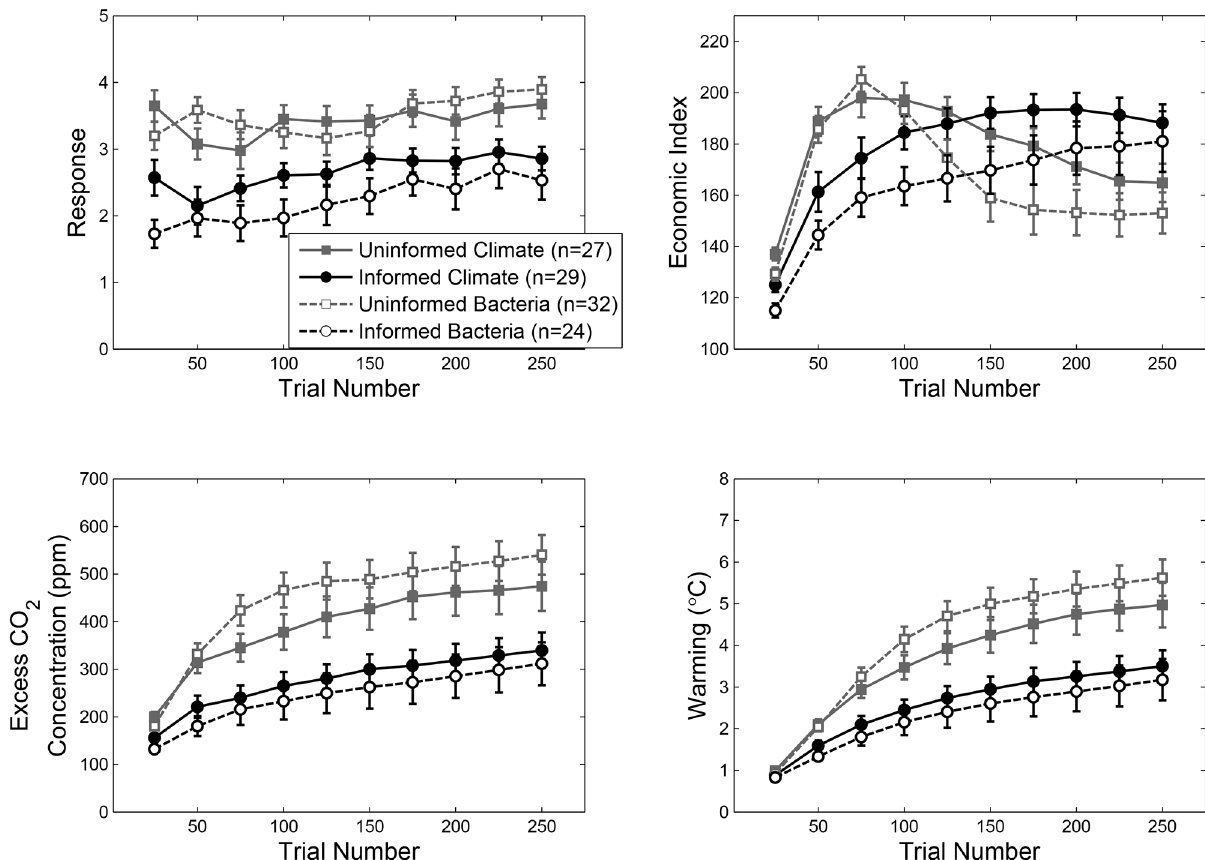
Fig 4. Data from Experiment 2. Panels show group averaged data for participantresponses (a), economicindex (b), excess CO 2 concentration (c), and warming(d). Error bars are one standarderror of the mean.